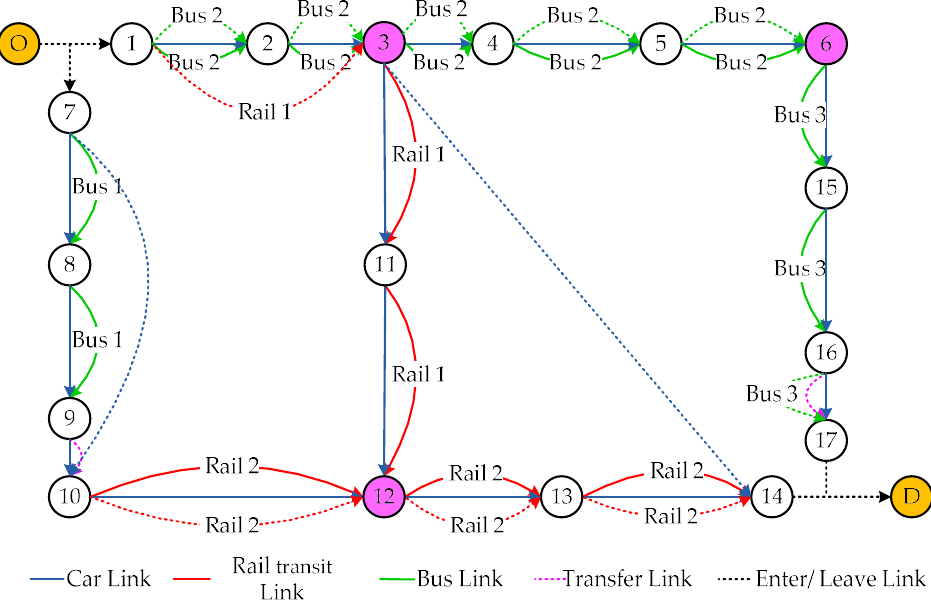
Figure 10. The diagram of optimization schemes.